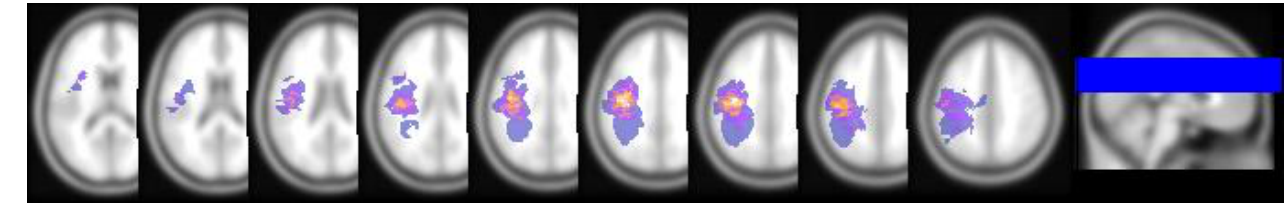
Figure 1. Methods and protocol. ( A )Twenty patients (10 with ISE and 10 without ISE) were included and experienced DTI and conventional MRI. ( B ) Diffusion metrics was preprocessed by PANDA toolbox. ( C ) Construct a white matter connectome matrix weighted by FN, FA, and FL. ( D ) Global and nodal topological properties were calculated and analysed.